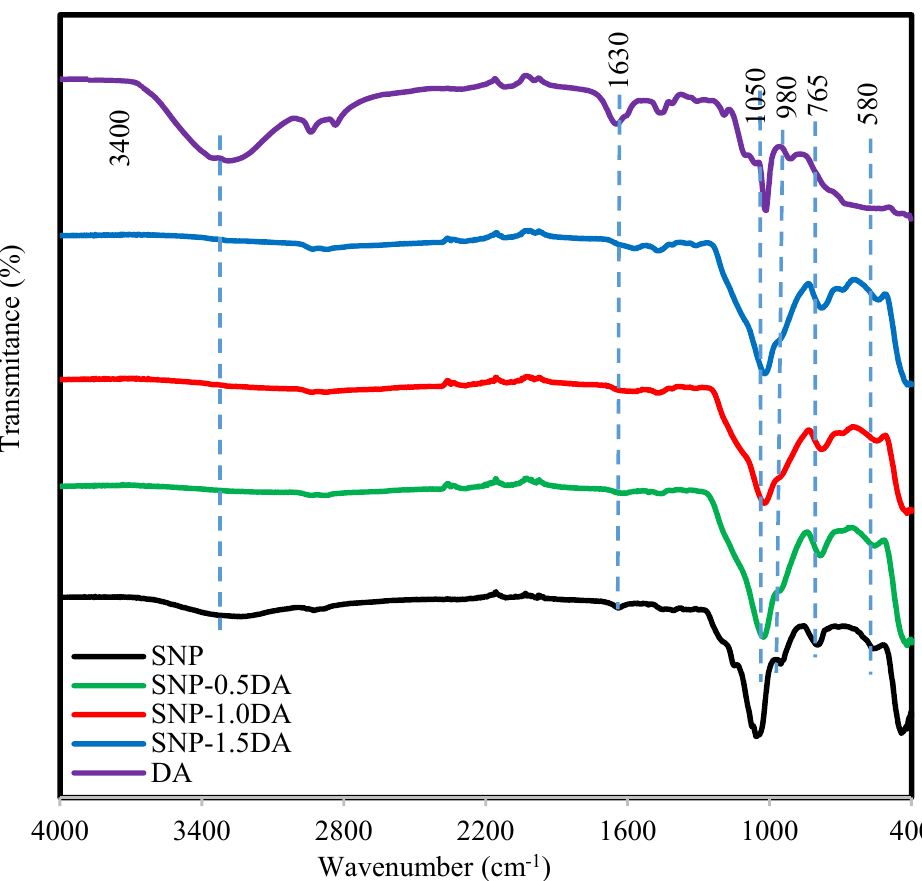
Figure 2. FTIR for the four nanocomposites and the DA over the wavenumber range of 400–4000 cm − 1 .